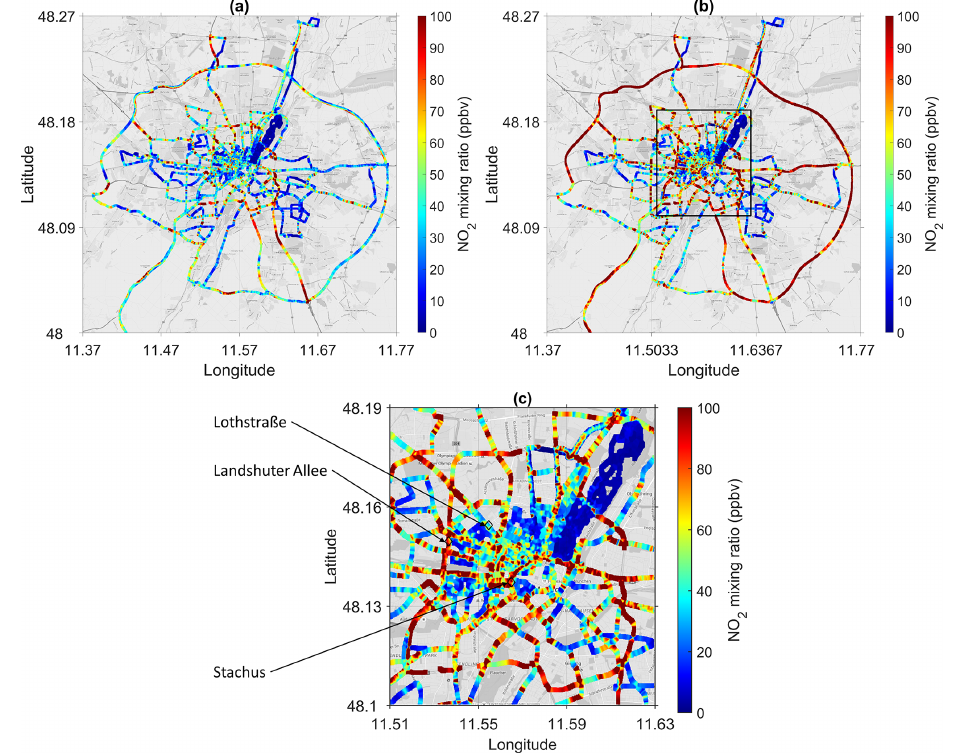
Figure 4. (a) CE DOAS and CAPS mobile measurements of NO 2 in Munich in 2016. (b) Normalized spatial distribution of NO 2 using coinciding LP DOAS data to remove the diurnal dependencies. (c) Close-up of the city center. The three black diamonds in panel (c) are the locations of the governmental monitoring stations (Landshuter Allee, Lothstraße, Stachus). The area at the top right with very low concentrations represents the city park English Garden. Map data © Google Maps. Table 2. Percentage of measured concentrations exceeding the WHO AQG 1h guideline and its corrected on-road level thresholds for both temporal and spatial coverage. The values are broken down for before and after the normalization of the data according to diurnal patterns and also calculated for WHO guideline values adjusted for the different measurement height and distance to the street. Percentage exceeding WHO guideline Percentage exceeding adjusted WHO guideline Before normalization After normalization Before normalization After normalization Temporally 4.4% 14.5% 1.7% 6.7% Spatially (total) 4.1% 17.1% Spatially